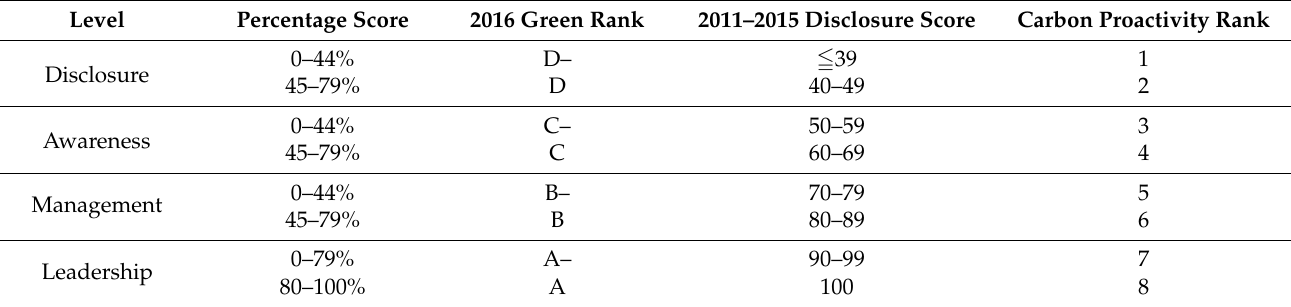
Table 2. Process for converting the four consecutive levels from fractions to